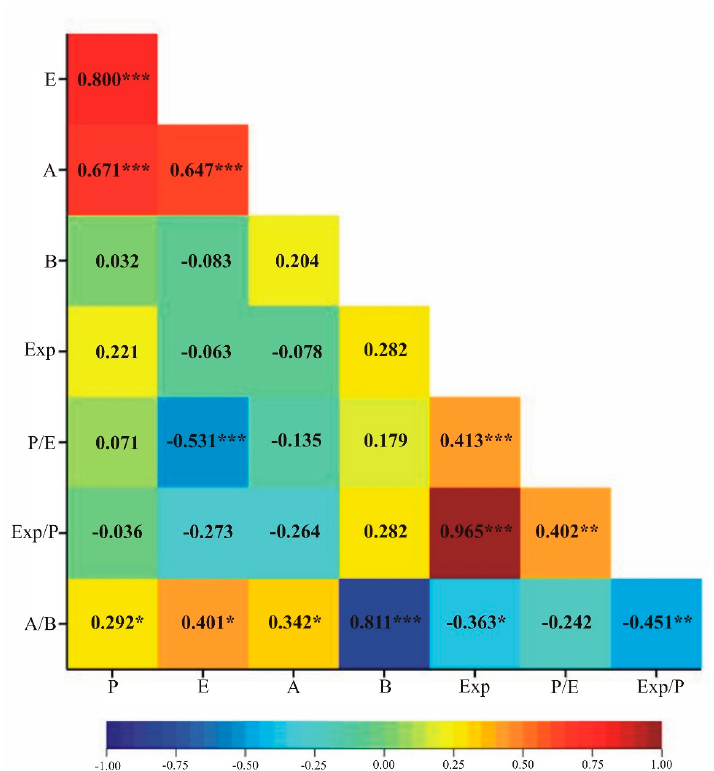
Figure 9. Heatmap for Pearson’s linear correlation coe ffi cients between observed traits (length of polar axis—P, equatorial diameter—E, width of the base of saccus—A, length of saccus—B, exine thickness—Exp, and P / E, Exp / P and A / B ratios) of Abies alba genotypes. A heatmap is a data visualisation technique that shows the magnitude of a phenomenon as colour in two dimensions. The